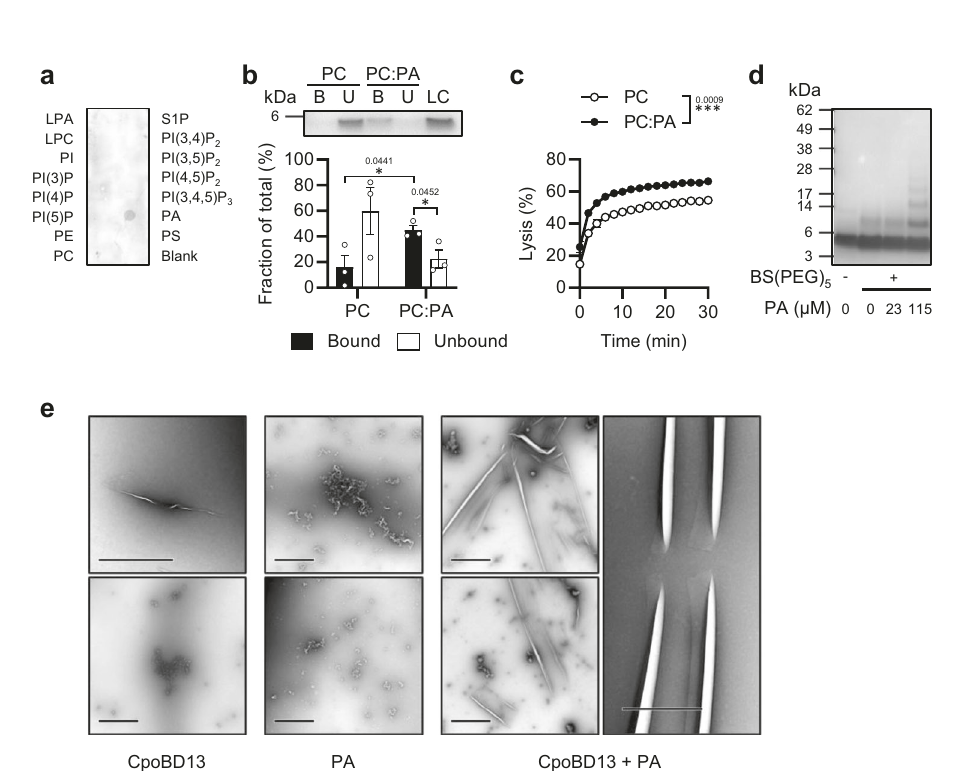
5 – 9 highlights a sharp decrease in positive charge at pH greater than 6.0. The theoretical net charge of the peptide was calculated using a simpli fi ed method based on the pK a of free amino acids. g Membrane permeabilisation of C. albicans treatedwithCpoBD13inconditionsbufferedtopH5.5,6.5and7.5.Datain(c – e&g) represent mean±SEM, n =3. h Live microscopy of C. albicans treated with 20 µ M CpoBD13conjugated to the fl uorophoreBODIPY FLEDA(green)inthepresence of PI (orange). Images are representative of three independent experiments. i Live microscopyofthe accumulationofCpoBD13-BODIPY(20 µ M, green) atthe plasma membrane of C. albicans cells. Scale bars represent 10 µ m. Images are representa- tive of three independentexperiments.(c – g) Source data are provided asaSource Data fi le.